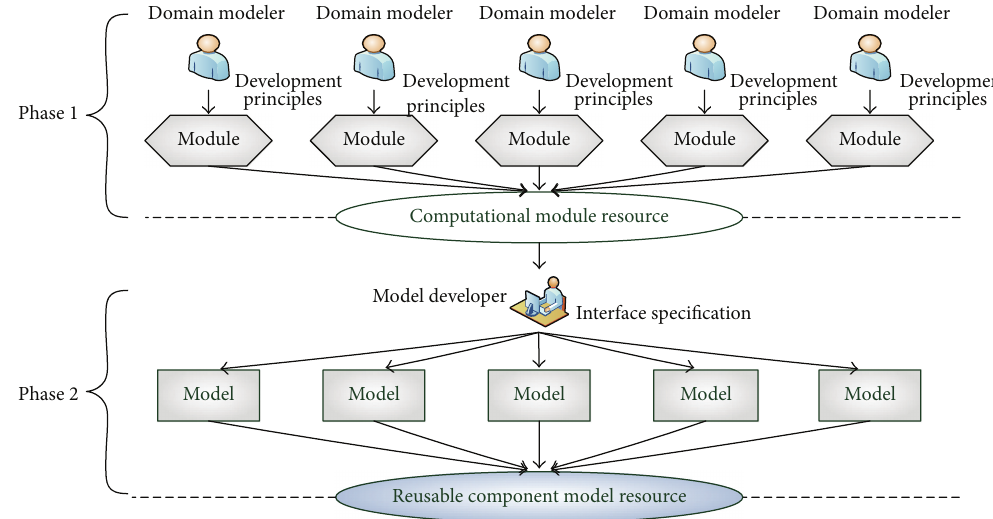
Figure 4: Two-phase reusable component model development